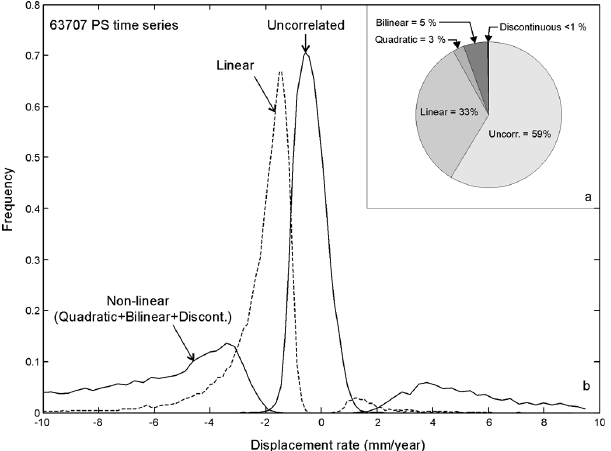
Fig. 9. Cluster analysis of the classified PS. The chart shows the spatial clustering of uncorrelated, linear, and non-linear PS (marked curves) with respect the overall distribution of unclassified PS (un- marked curve). Dashed lines indicate the expected distribution of the classified PS (at 99% confidence interval) in the hypothesis of a random dispersion within the parent dataset.